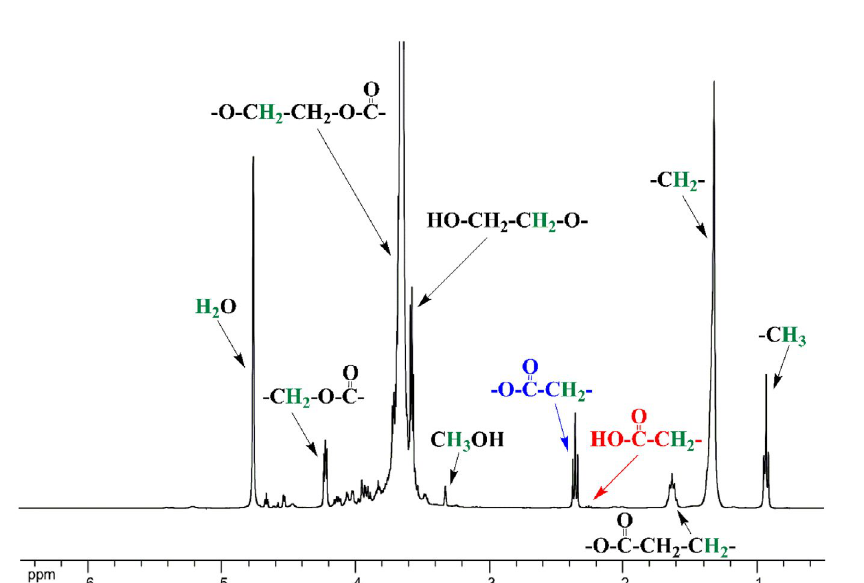
Fig 2. 1 H NMR spectrum of the fresh PS 20 sample recorded in CD 3